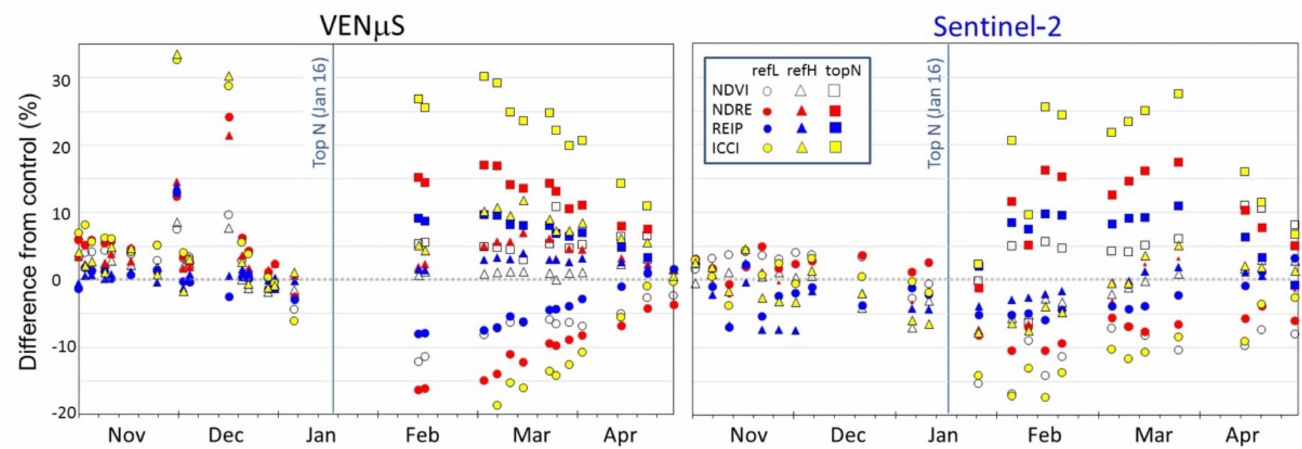
Figure 11. Reference strip or topdressed N managements: VEN µ S- and Sentinel-2-based NDVI, NDRE, REIP, and ICCI difference from the commercial management along the growing season. Beit Guvrin 2020 (Field 109). REIP difference was calculated based on REIP-700. VEN µ S operation caused missing period January–February